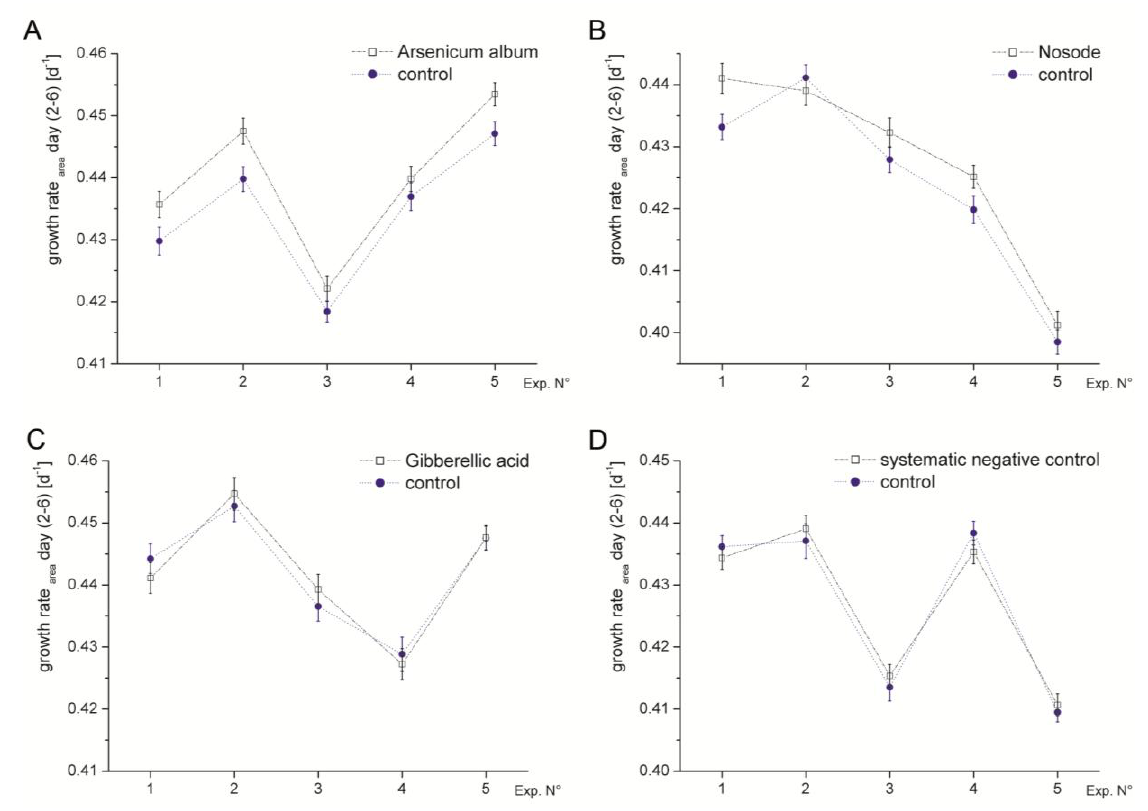
FIGURE 4. Growth rate of L. gibba L. (r (area) days 2–6) [d -1 ] (mean ± standard error) treated with different homeopathic preparations: (A) Arsenicum album; (B) nosode; (C) gibberellic acid. Data for the nine potency levels (17x, 18x, 21x–24x, 28x, 30x, 33x) were pooled and compared to the pooled data for the nine control samples (four samples unsuccussed water, five samples succussed water). The systematic negative control experiment (D) compared 45 randomly allocated samples of unsuccussed water with another 45 randomly allocated samples of unsuccussed water. All four experimental series (A–D) comprised five independently performed experiments (Exp. N°). Lines connecting data points are no